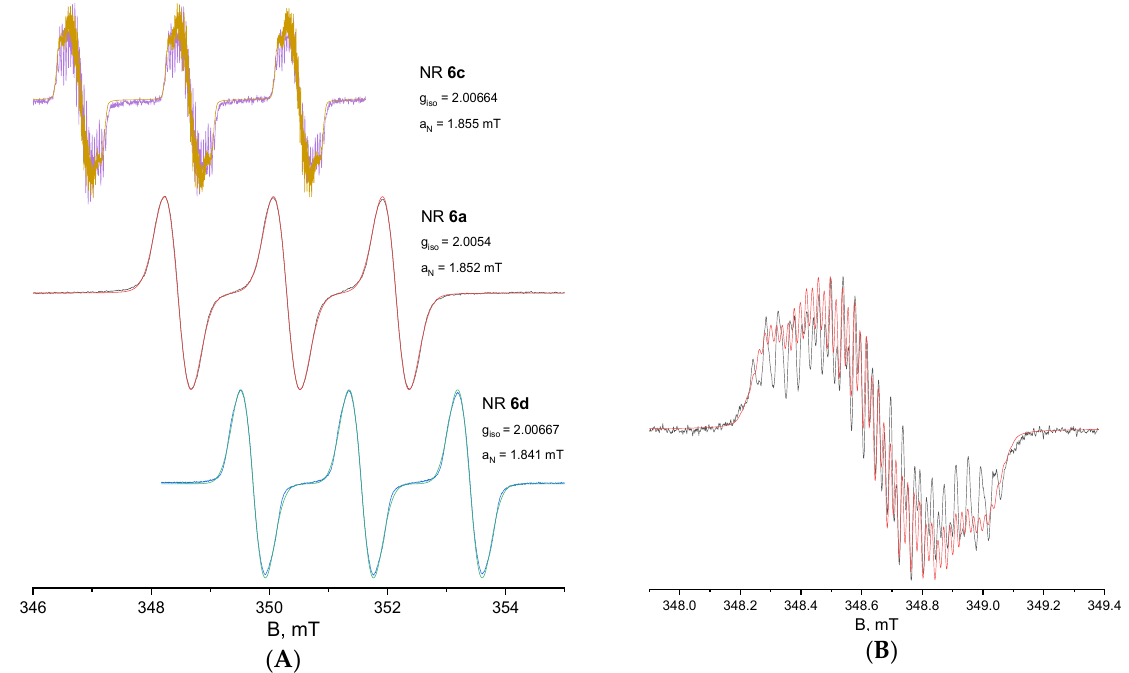
Figure 2. ( A ) EPR spectra of new bicyclic nitroxides, from the top: radicals 6c , 6a , and 6d . ( B ) The center line in the spectrum of NR 6c . The black line: experimental spectrum, red line: mathematical reconstruction.